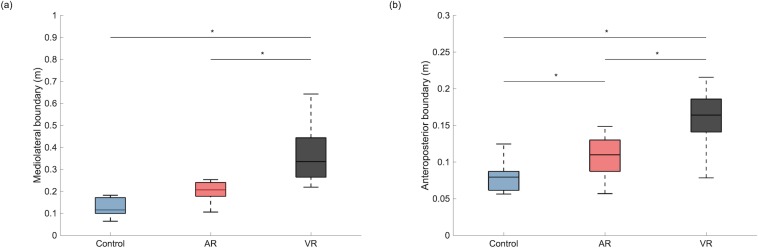
The group average and standard deviation of the (a) mediolateral and (b) anteroposterior boundary of the center of pressure ellipse under different walking conditions. AR: augmented reality; VR: virtual reality. Asterisk (*) denotes p<0.05 in the corresponding pairwise comparison.